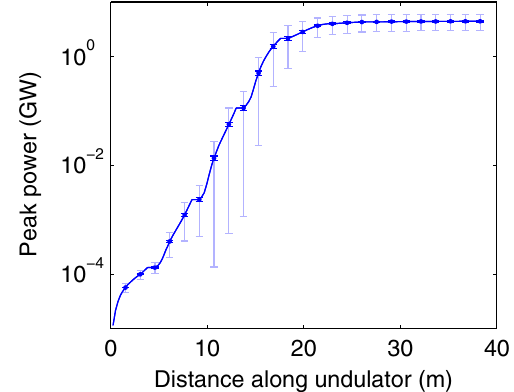
FIG. 15. Mean power growth along the undulator for 100 different random seeds. Calculations are performed including realistic gun and linac errors. Bold error bars show the error on the mean value; faint error bars show standard deviation.